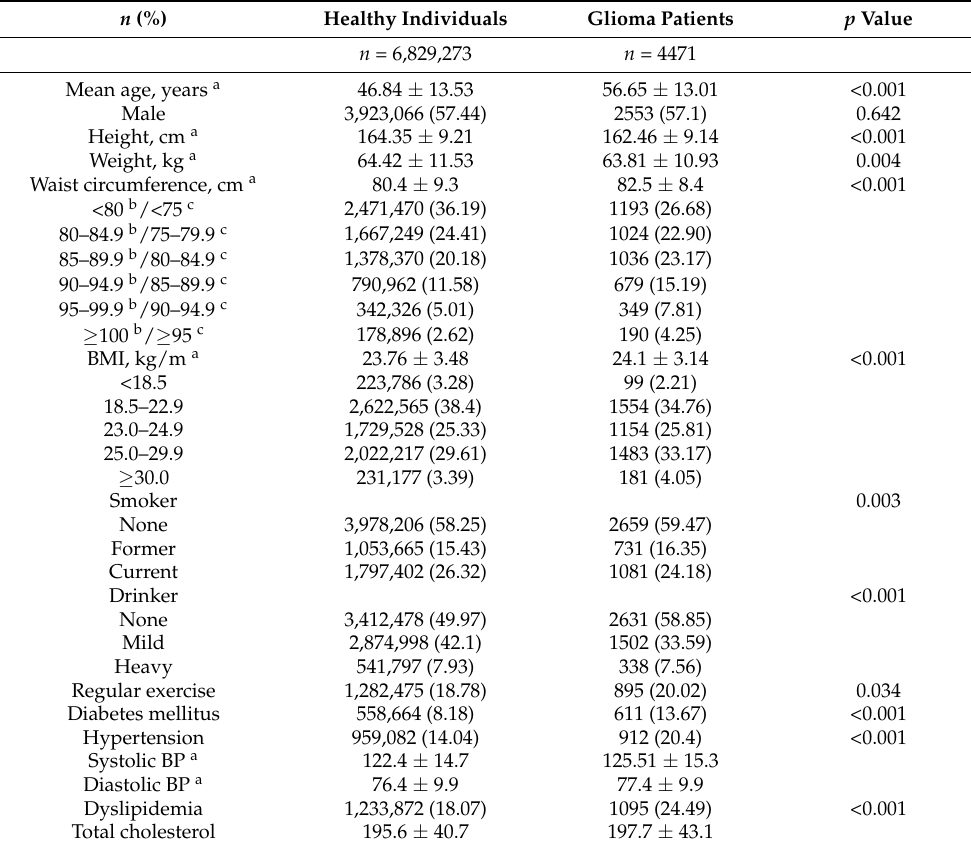
Table 1. Baseline characteristics of the study population.